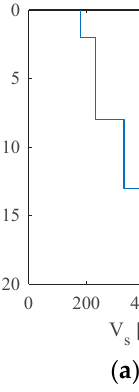
Figure 6. Dynamic characterization of the soil: ( a ) setup for the experimental activities; ( b ) experi- mental P-SV dispersion relationship.